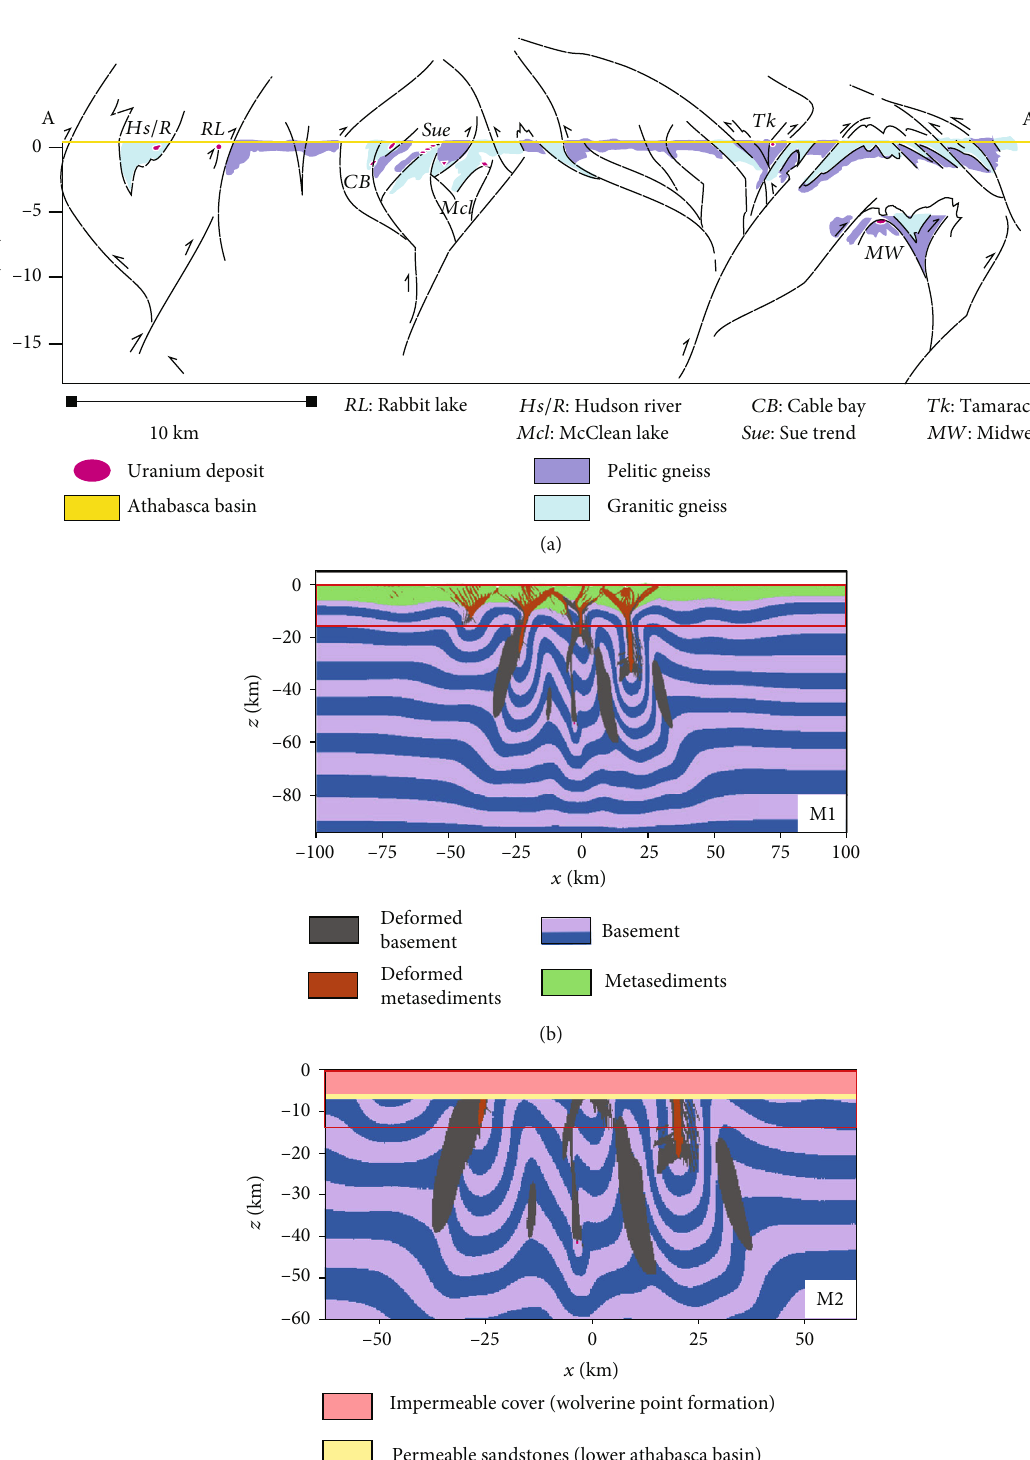
Figure 2: (a) Generalised cross-section of the Wollaston-Mudjatik Transition Zone with the location marked in Figure 1(a) inset. Modi fi ed from [16] and Benedicto et al. [35]. Thermomechanical model outputs, (b) M1 and (c) M2, from Poh et al. [39] are used as inputs to generate reference models for fl uid-thermal simulation shown in Figure 3. Red rectangular boxes in (b) and (c) show the physical dimensions of the hydrothermal models which are conducted in this study, respectively. The geometry and spacing of the anastomosing fault systems in (a) appear to be in good agreement with the vertical structures generated in the thermomechanical models in (b) and